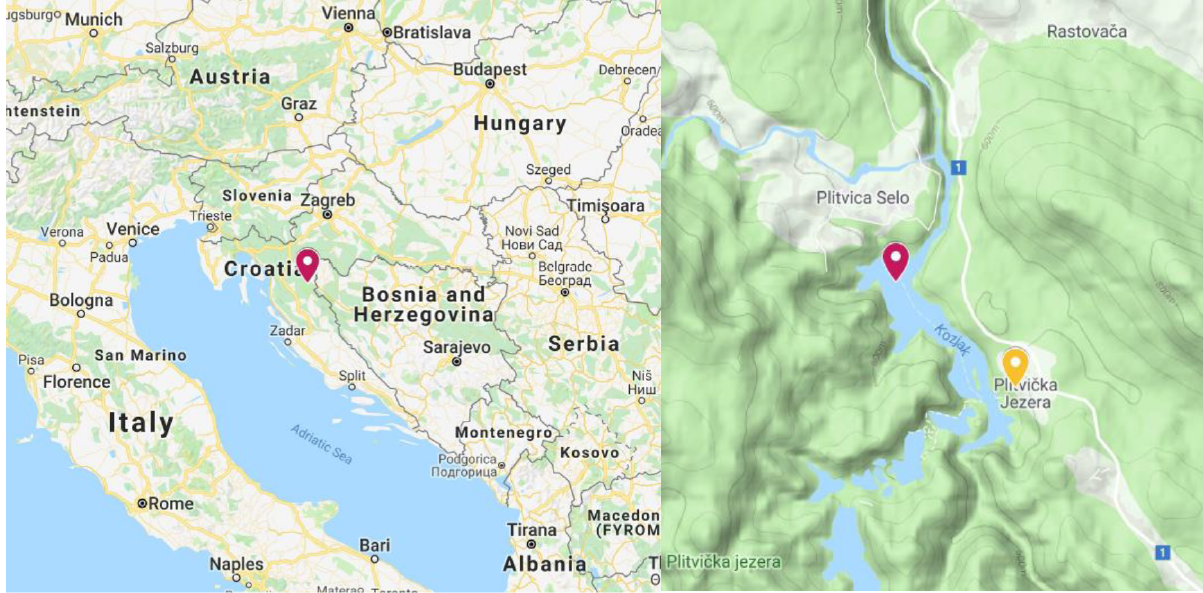
Figure 1. Location of Kozjak Lake (red pin, left panel). A closer look at Kozjak Lake (right panel). The locations of the lake temper- ature measuring point ( ϕ = 44 . 8902 ◦ N, λ = 15 . 6038 ◦ E, height of the lake surface 535ma . s . l . ) and the meteorological measuring site ( ϕ = 44 . 8811 ◦ N, λ = 15 . 6197 ◦ E, 579ma . s . l . ) are shown by the red and yellow pins in the right panel, respectively. (Source: © Google